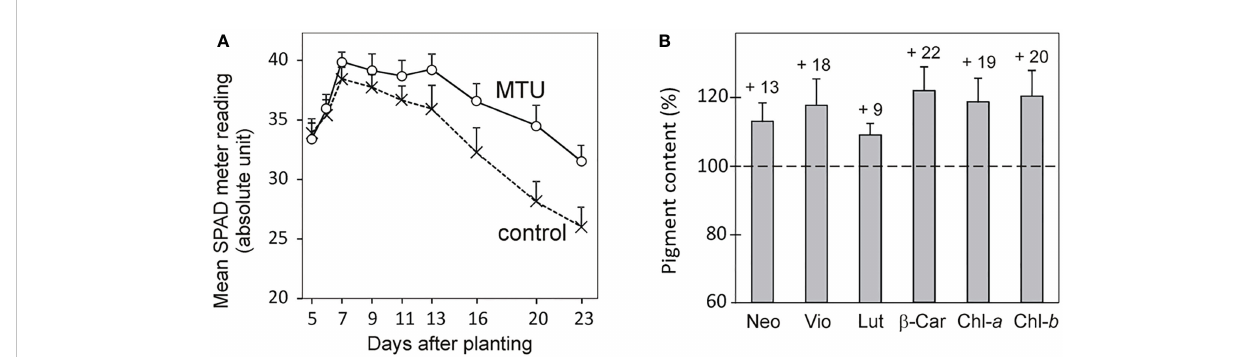
FIGURE 2 The pigment content in wheat seedlings treated by MTU. (A) The chlorophyll content in the fi rst leaves of wheat. Values are means ± SD of 15 biological replicates. All differences from day 7 onwards are statistically signi fi cant at P < 0.003 based on two ‐ tailed Student ’ s t ‐ tests. (B) Content of photosynthetic pigments in shoots of 20-day-old wheat plants treated with MTU relative to untreated control plants (dashed line). Values are means ± SD of seven biological replicates. All differences are statistically signi fi cant based on two ‐ tailed Student ’ s t ‐ tests at P < 0.02. Numbers above each column show percentage increases. Neo, neoxanthin; Vio, violaxanthin; Lut, lutein; b -Car, b -carotene; Chl- a , chlorophyll a ; Chl- b , chlorophyll b